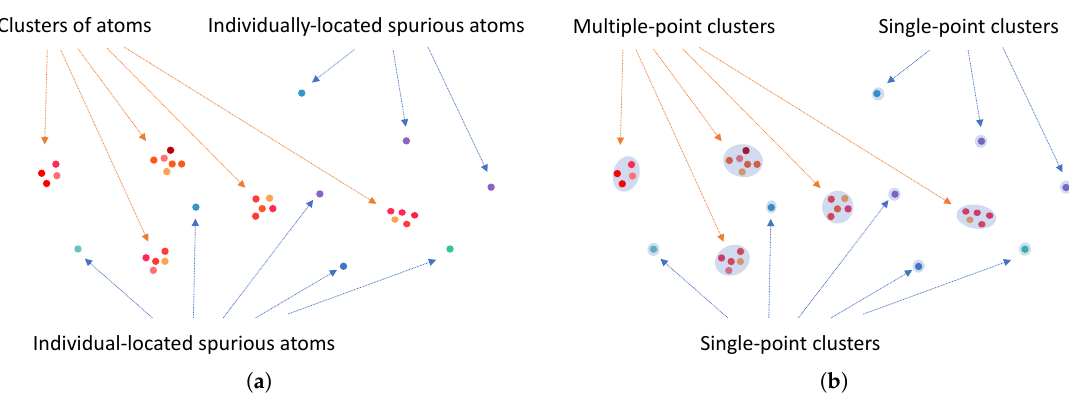
Figure 4. Example illustration of input and output for Stage I: ( a ) input of Stage I (before performing cluster analysis); ( b ) output of Stage I (after performing cluster